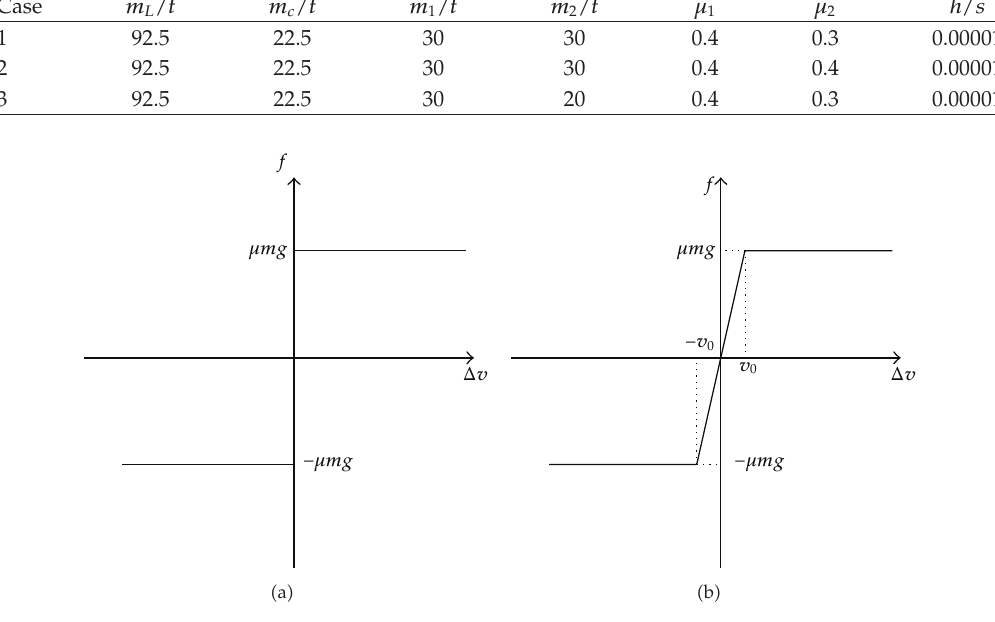
Figure 5: One-dimensional friction element